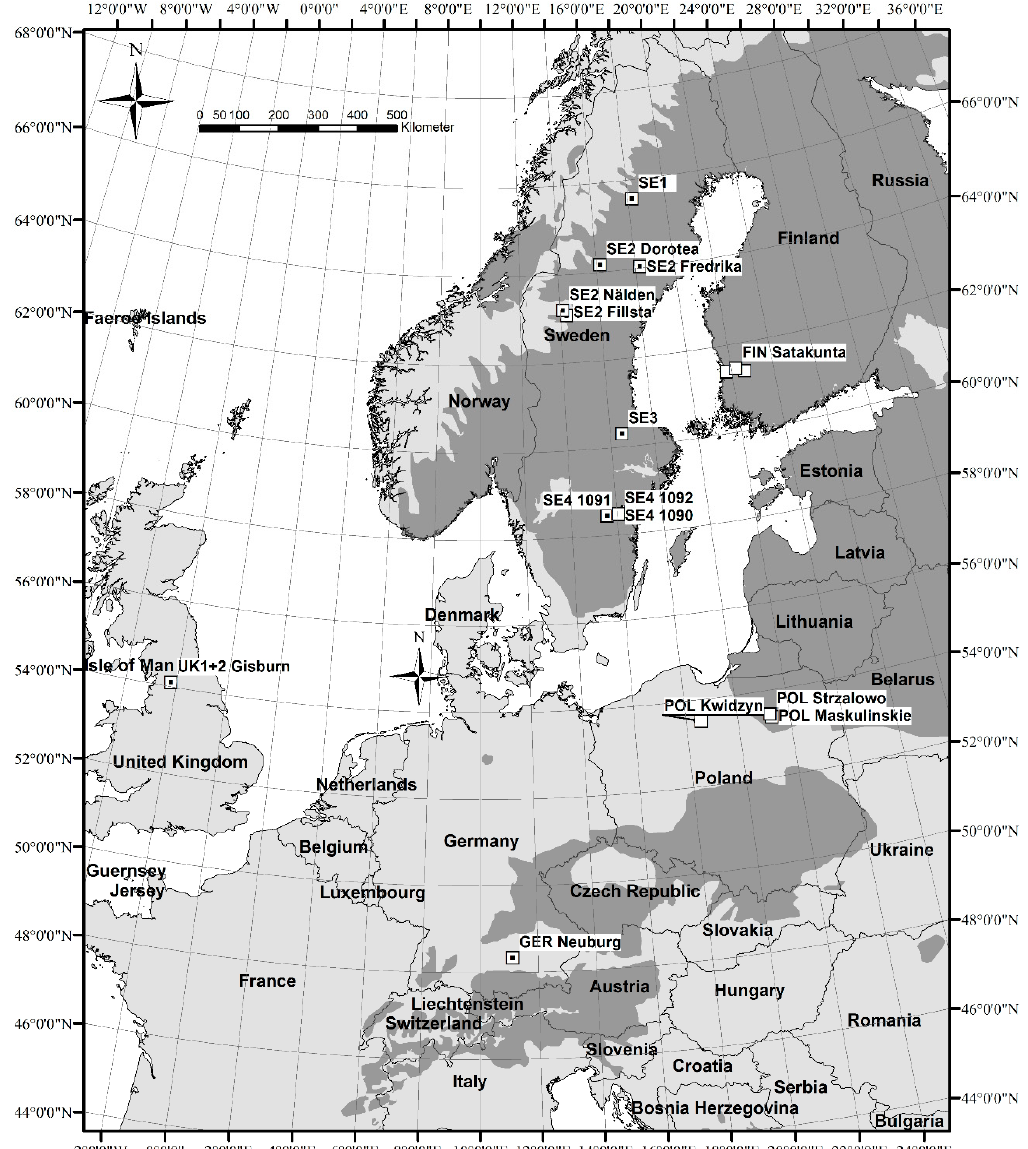
Figure 1. The overlapping area of the natural distribution of Norway spruce and Scots pine in Northern and Central Europe (dark grey color), and the distribution of study sites: White squares with black dots indicate sites containing all three treatments, white squares indicate sites with age up to 10 years (FIN) or lacking the treatment “Norway spruce monoculture” (POL, SE4 1090, SE4 1092). Source: EUFORGEN 2013 GIS database [5].